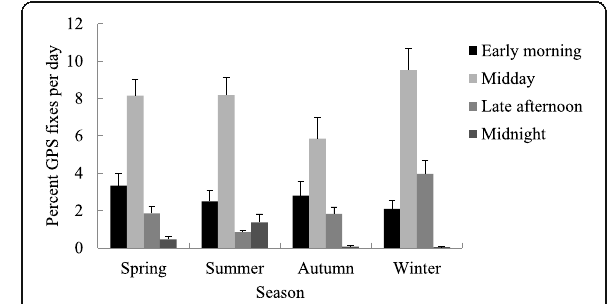
Fig. 9 Percentage and standard error of the number of GPS fixes 30 m around supplemental feed locations per day of a free-ranging cattle herd ( N = 11) during four 3-h time periods for eight trials of 3 weeks from September 2007 to August 2008 in a semi-arid rangeland in South Texas,